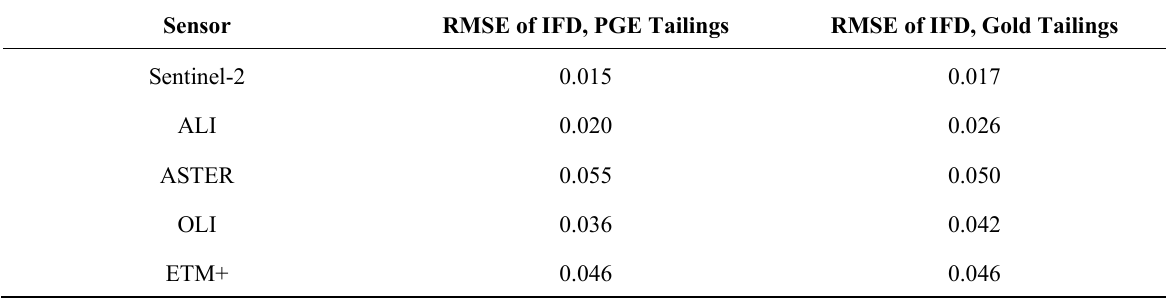
Table 4. Root-mean-square error of iron feature depth calculated from resampled ASD field-spectroscopy